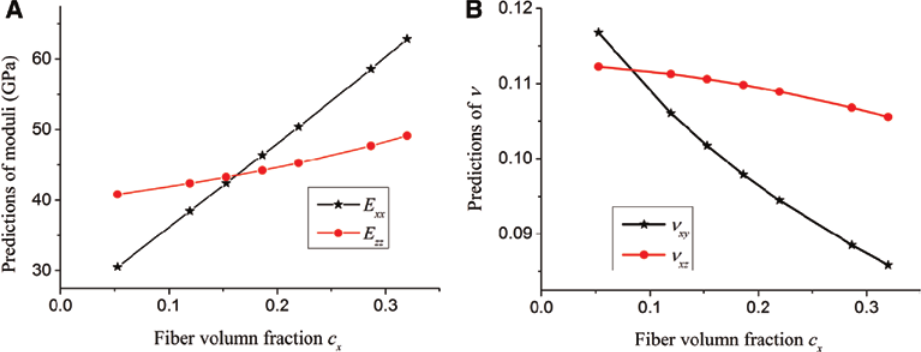
Figure 20: Effect of c